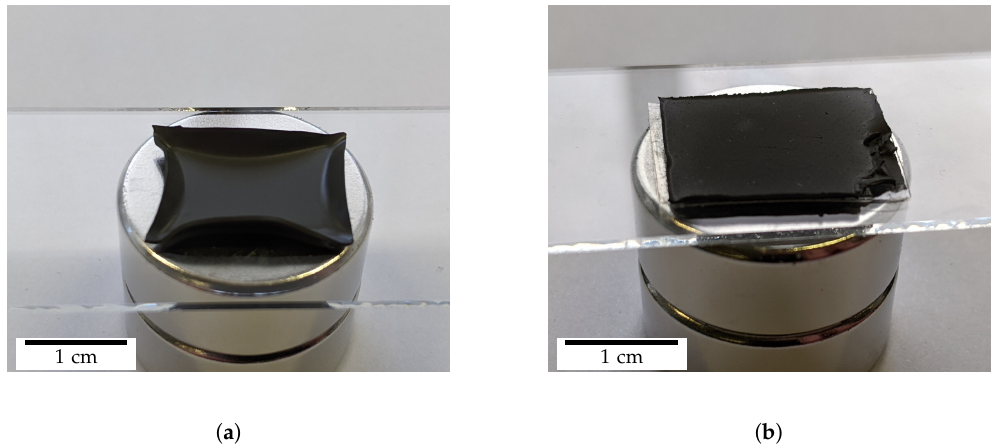
Figure 3. Deformation of MAE films on the permanent magnet magnetized along its height. ( a ) MAE film without plastic substrate. ( b ) MAE film on the plastic